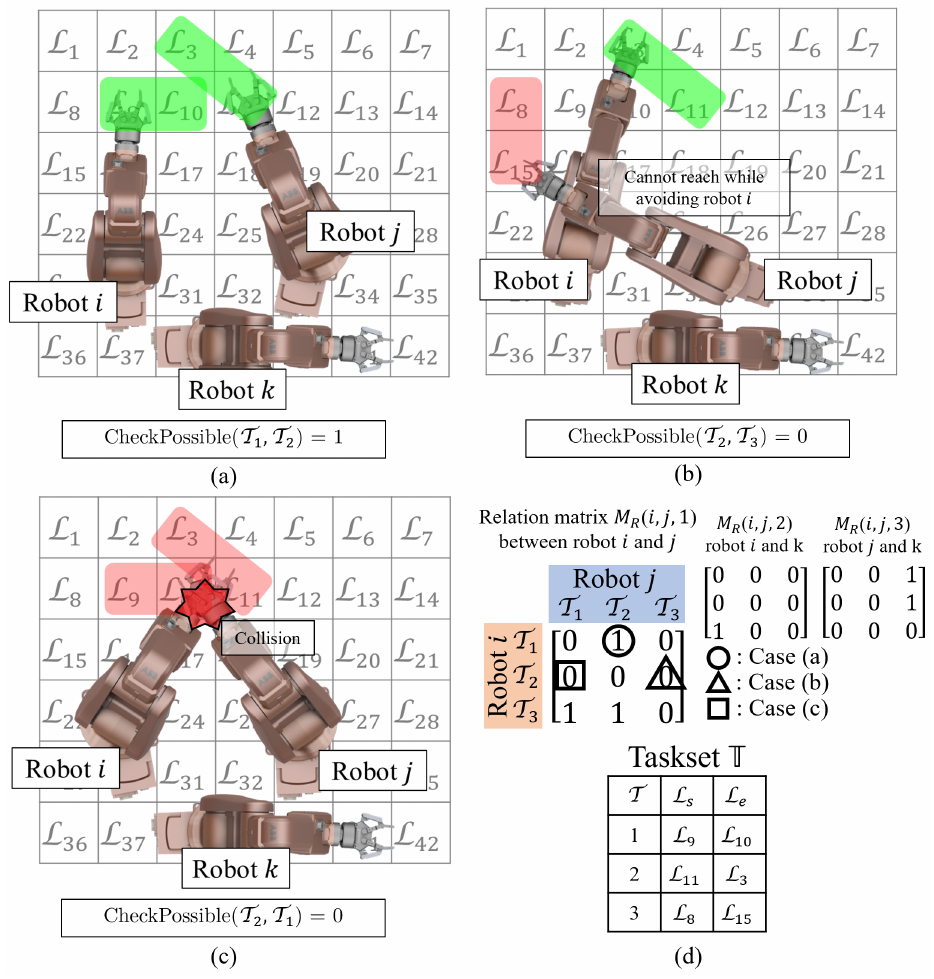
Figure 1. Examples for explaining the Relation Matrix. C HECK P OSSIBLE ( T i , T j ) is the function that checks whether robot i and robot j can conduct two tasks concurrently. ( a ) The case in which the robots can conduct two tasks. ( b ) The case in which the robot j cannot reach the third task location. ( c ) The case in which the robots collide with each other. ( d ) Example taskset and M R used for the example. M R ( i , j ,1 ) follows the result of C HECK P OSSIBLE ( T i , T j )